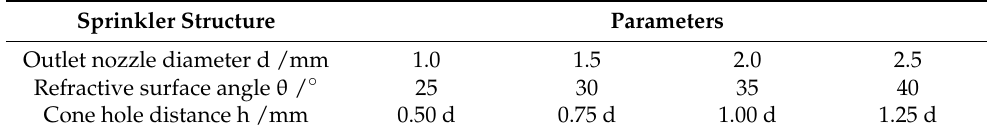
Table 1. Structural parameters of the irrigation water.